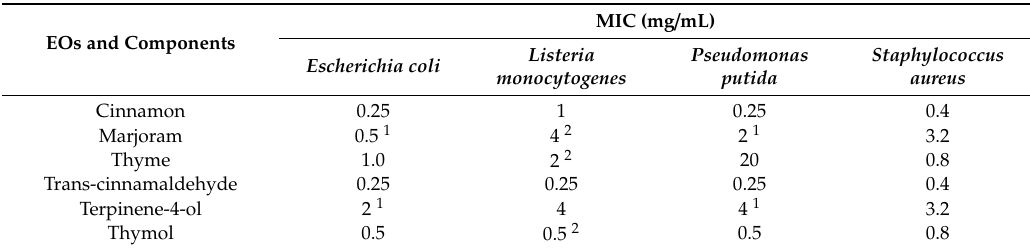
Table 1. Minimum inhibitory concentration (MIC) of essential oils (EOs) and their components against the food-related bacteria